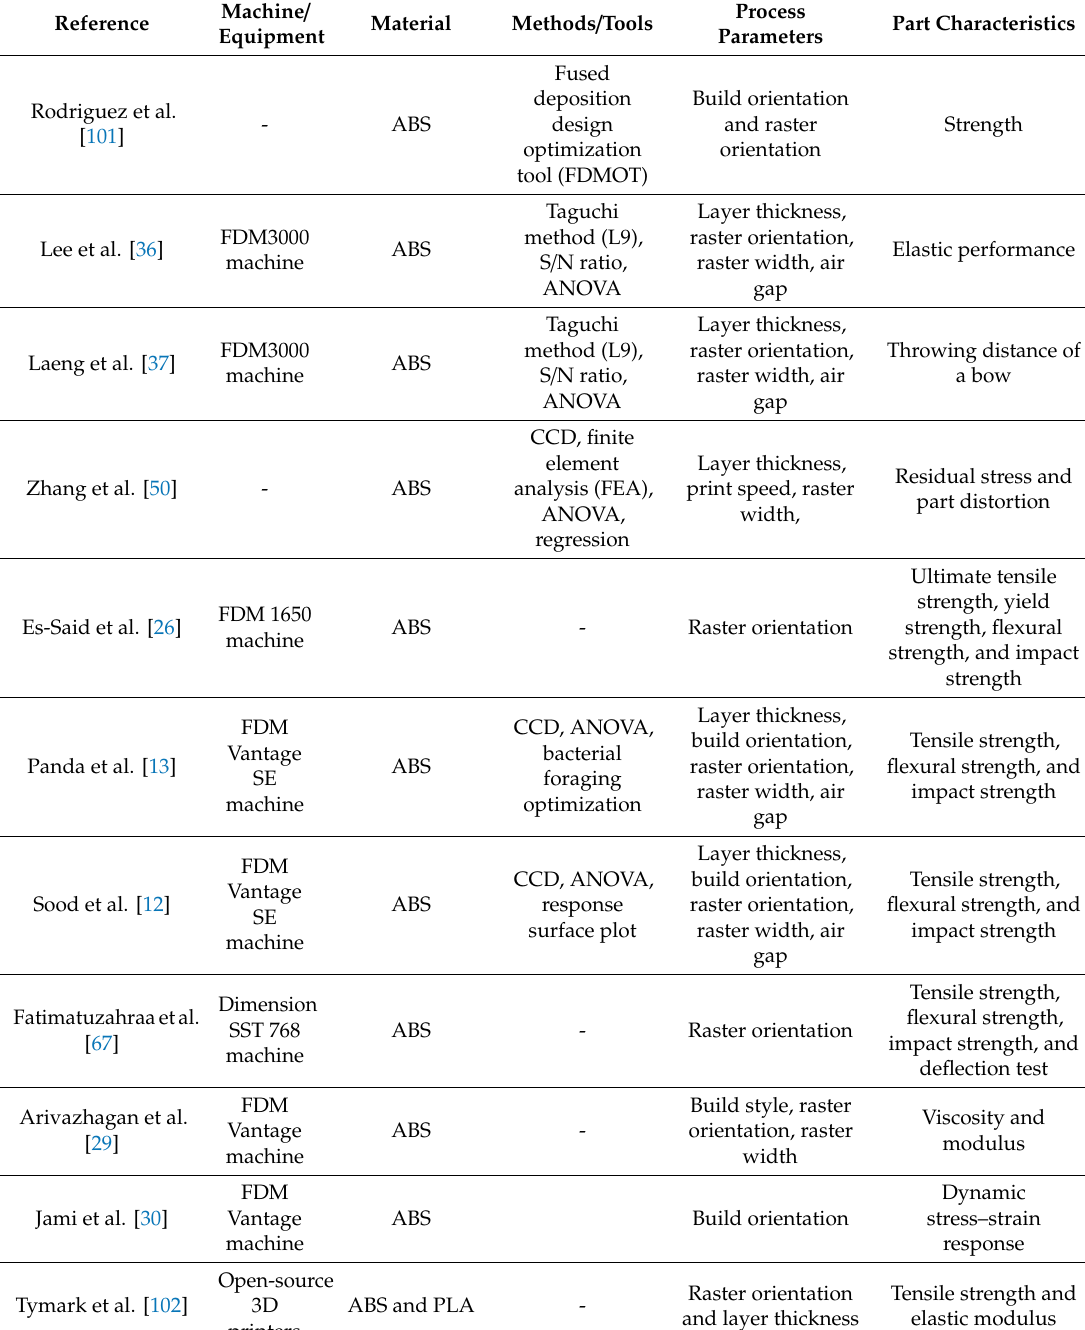
Table 2. Studies focusing on process parameter analysis. S / N—signal-to-noise; CCD—central composite design; RSM—response surface method; ANN—artificial neural network; GA—genetic algorithm; DoE—design of experiment; PC—polycarbonate; CABS—conductive ABS; PEEK—polyether ether